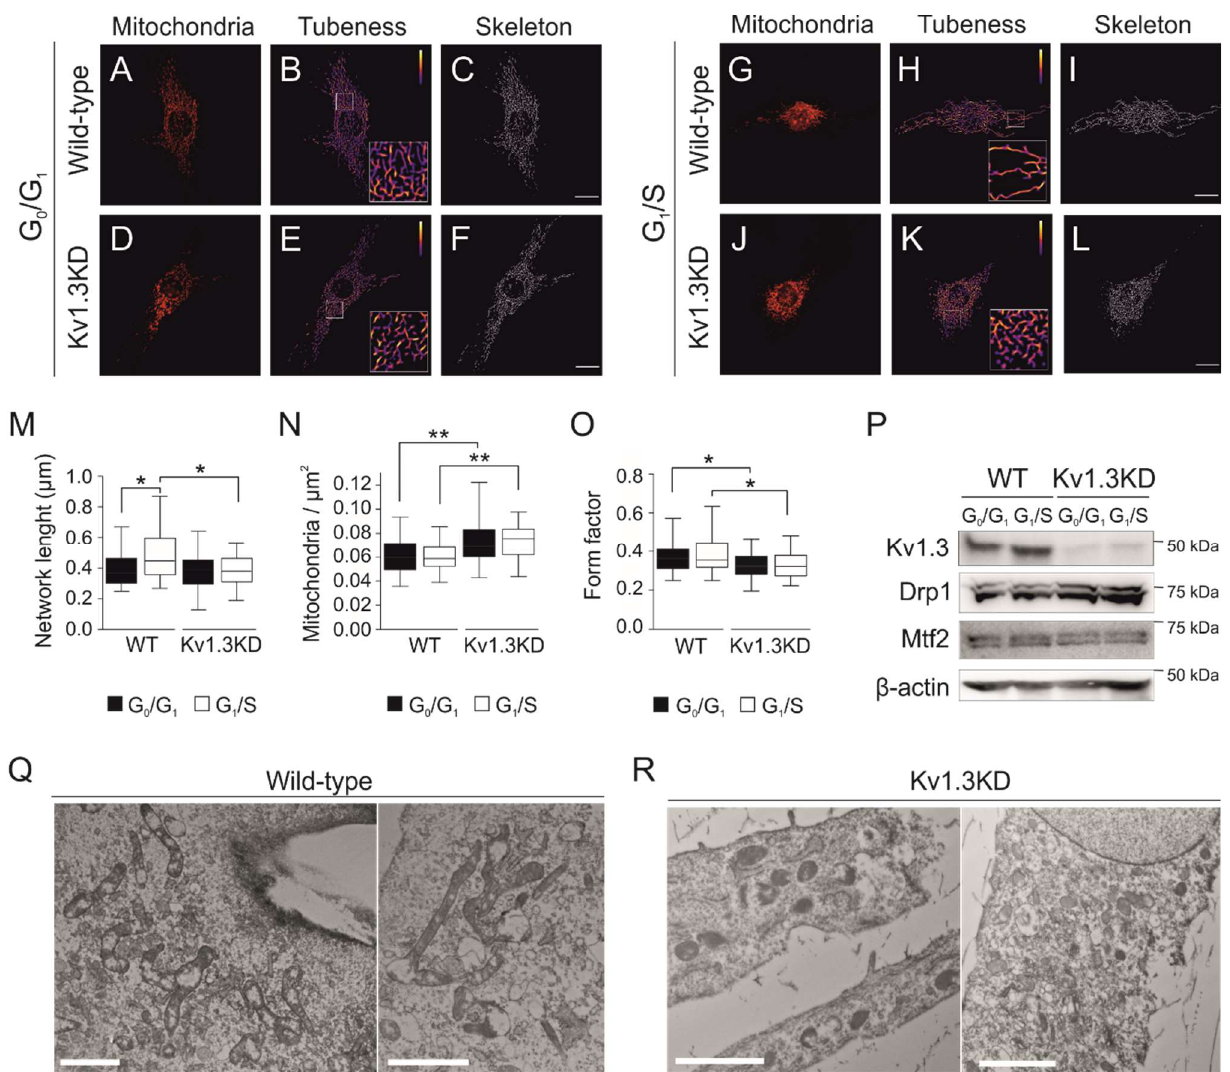
Figure 4. Kv1.3 regulates the mitochondrial fusion/fission equilibrium during the G1/S transition. Confocal images showing mitochondria in cells fixed in the G0/G1 ( A – F ) and G1/S ( G – L ) phase for WT ( A – C , G – I ) and Kv1.3KD preadipocytes ( D – F , J – L ). The scale bar represents 20 μm. Images were processed (tubeness and skeleton) to perform morphometric analysis of mitochondria. ( M ) The length of mitochondrial networks was measured as the average area of the skeletonized binary image. ( N ) Number of mitochondrial particles per μm2. ( O ) The form factor describes the particle shape complexity and was computed as the average (perimeter)2/(4π·area). A circle corresponds to a minimum value of 1. The data are the mean ± SE ( n > 30). *, p < 0.05; **, p < 0.01 (one-way ANOVA). ( P ) Protein expression of Kv1.3, dynamin-related protein 1 (Drp1) and mitofusin 2 (Mtf2) during the G0/G1 and G1/S phase in WT and Kv1.3KD 3T3-L1 preadipocytes. β-actin was used as a loading control. ( Q , R ) Electron micrographs showing mitochondria of WT ( Q ) and Kv1.3KD ( R ) 3T3-L1 preadipocytes during the G1/S phase. Note that, unlike those in Kv1.3KD, mitochondria in wild-type cells were highly fused.